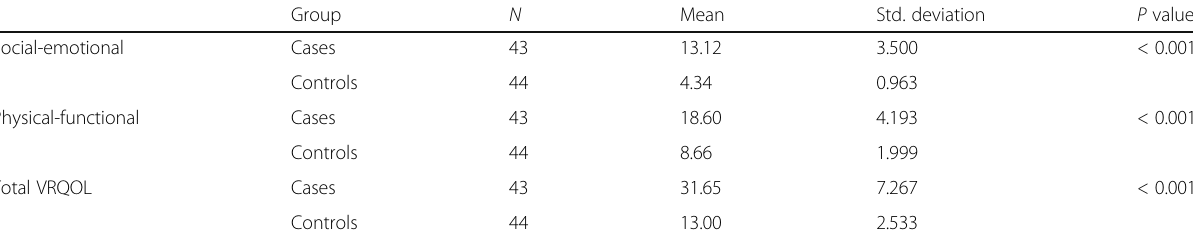
Table 5 Comparisons of means between case and control groups in regards to subdomain scores and total V-RQOL score Group